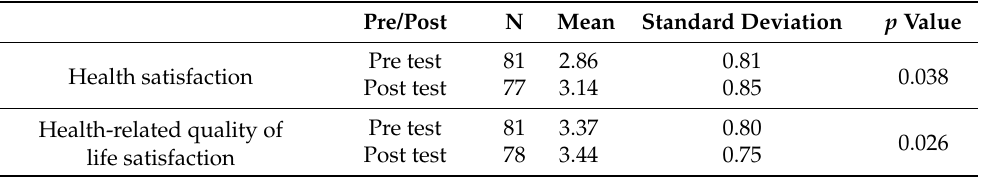
Table 3. Health promotion lifestyle satisfaction of diabetic patients.